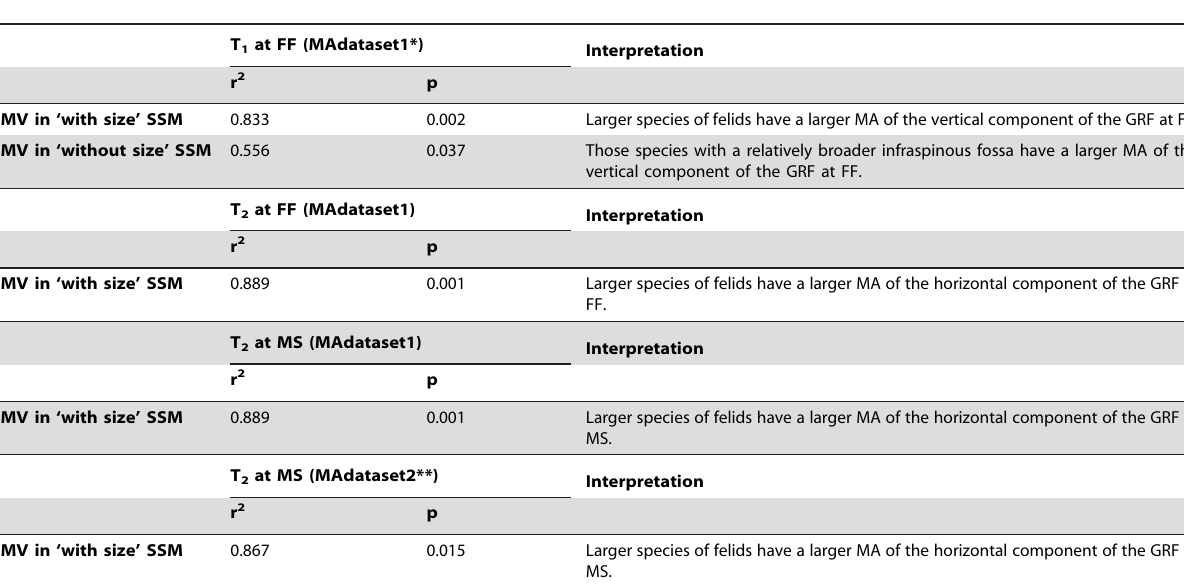
Table 3. Results of correlation tests between MAs and MVs in the ‘with size’ and ‘without size’ SSMs.